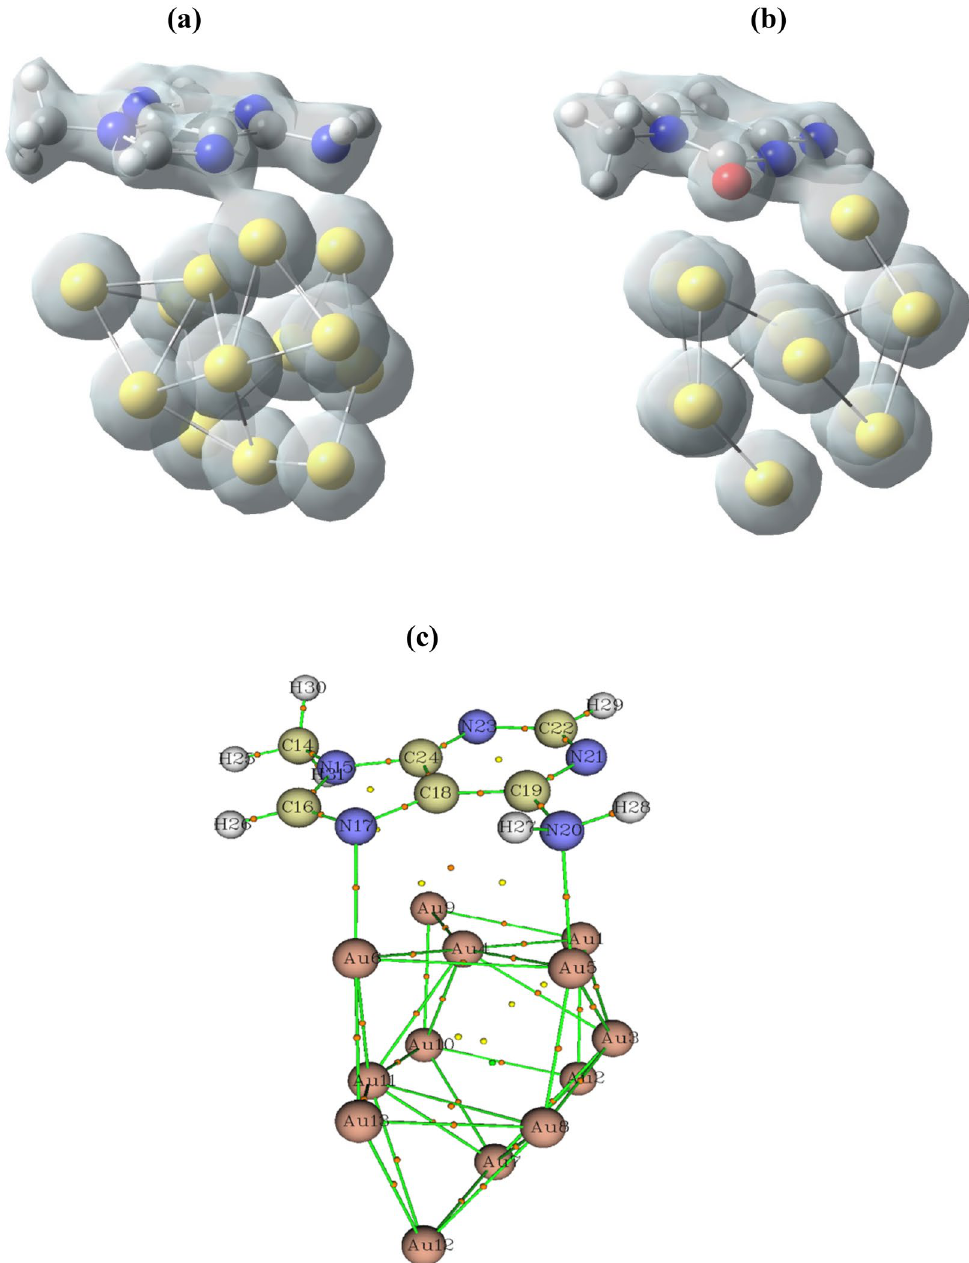
Figure 3. Calculated total electronics charge for ( a ) adenine/Au13 and ( b ) cytosine/Au13 systems with DFT - D3/TZVP (iso-value was set to 0.07). ( c ) Calculated bonding critical points (BCPs) for adenine/Au13 system with DFT ‒